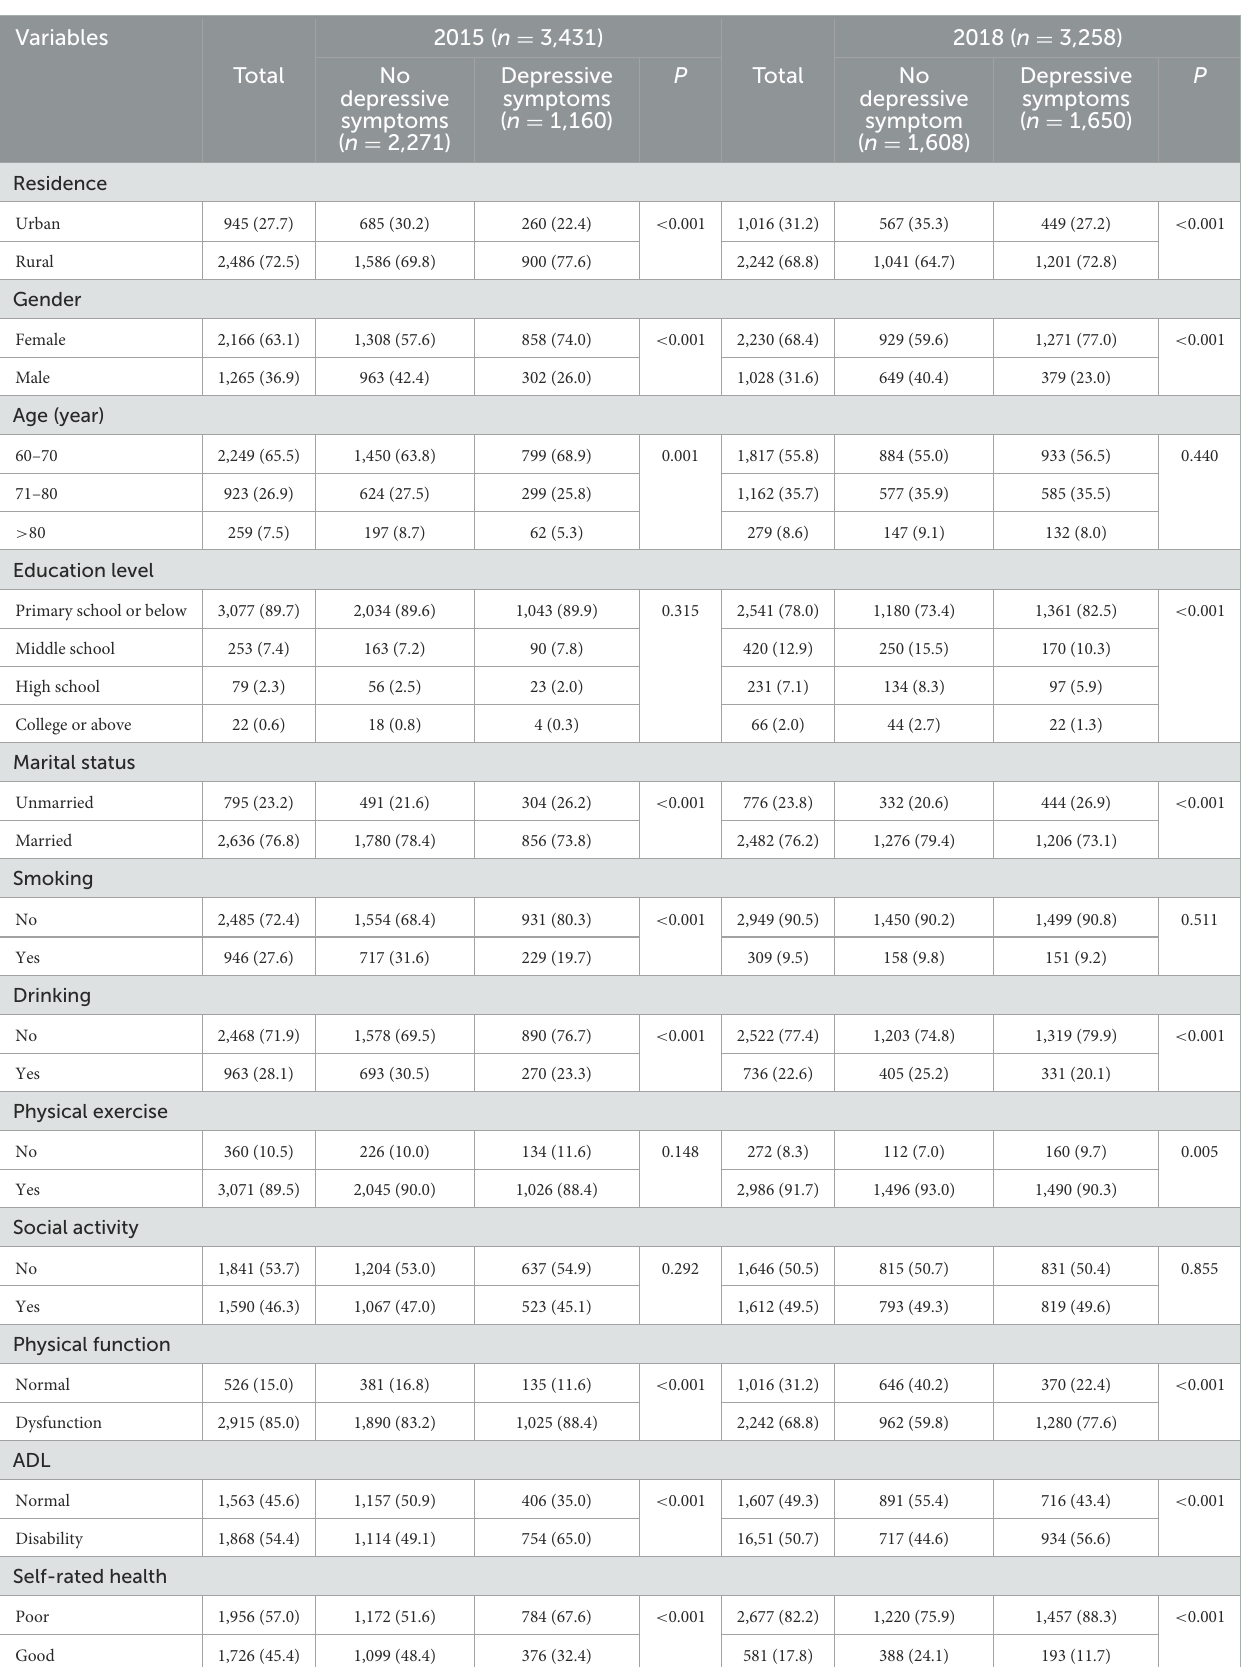
TABLE 1 Demographic characteristics and depressive symptoms in elderly [ N